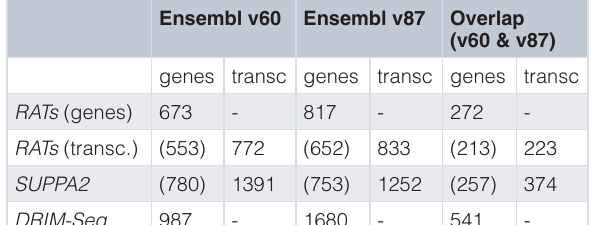
Table 4. Overlap between the DTU results from RATs , SUPPA2 and DRIM-Seq , for quantification of the Deng et al. (2013, 31) dataset based on Ensembl v87. The overlaps are shown as the proportion of the results from the methods on the columns captured by the methods on the